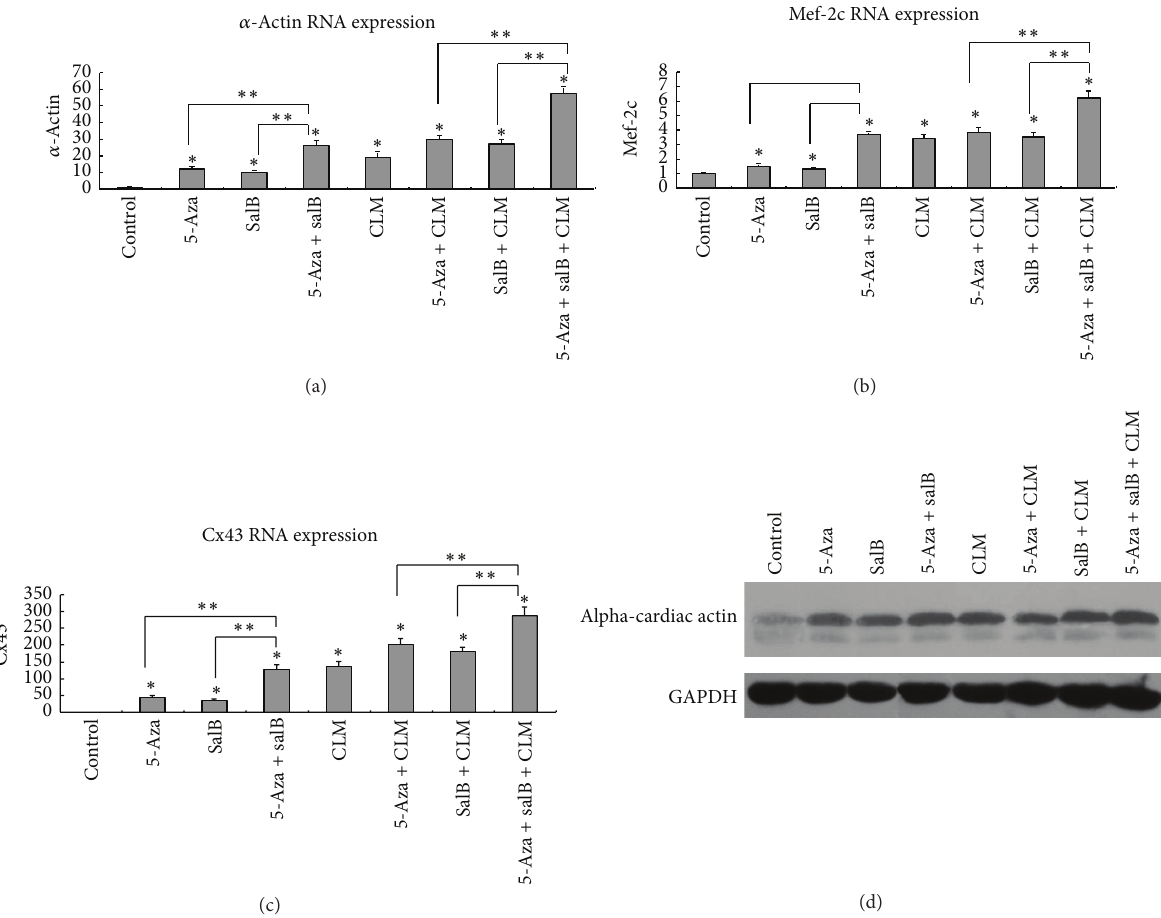
Figure 5: mRNA expression of alpha-cardiac actin, mef-2c, and cx43 detected by qPCR. The reference gene is GAPDH, and its threshold cycles were 22. (a) Alfa-actin mRNA expression; (b) mef-2c mRNA expression; (c) cx43 mRNA expression. (d) Alpha-cardiac actin protein expression. Results are shown as the mean ± SD values. Experiments were repeated three times. ∗ 𝑃 < 0.05 compared to the control group. ∗∗ 𝑃 < 0.05 compared between the two groups as shown in the